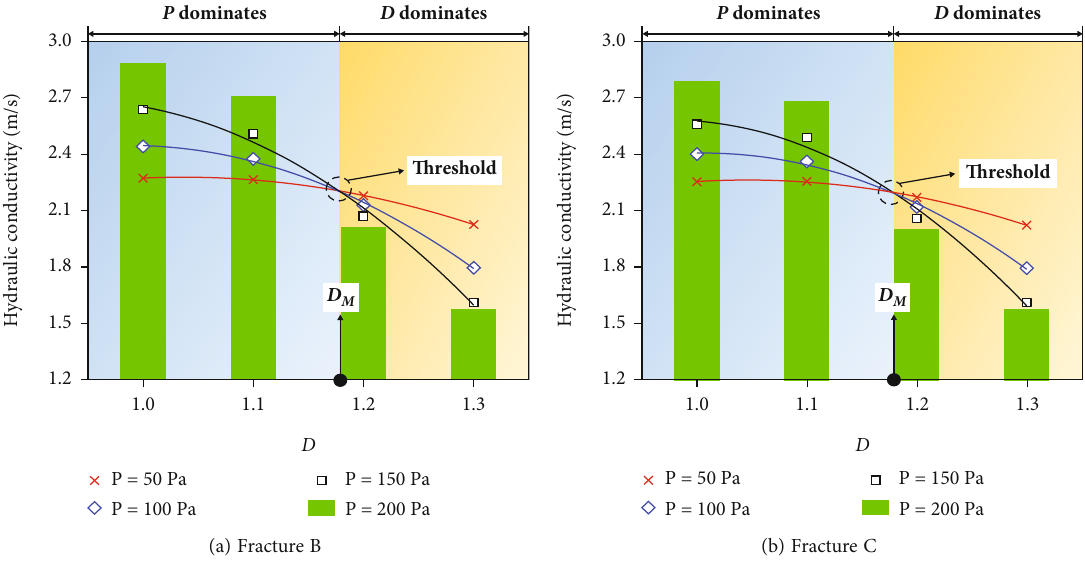
Figure 7: Evolution of hydraulic conductivity with fractal dimension.